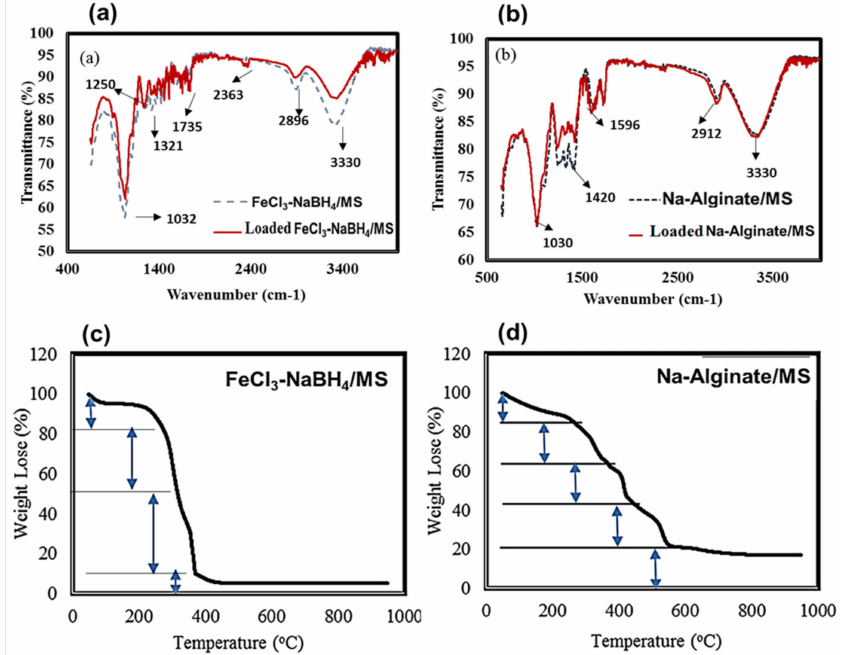
Figure 1. FTIR spectra of ( a ) FeCl 3 -NaBH 4 /MS hybrid composites and ( b ) Na-Alginate/MS compos- ite beads, both for loaded and unloaded 2,4,6-TCP, and TGA thermograms for ( c ) FeCl 3 -NaBH 4 /MS hybrid composites and ( d ) Na-Alginate/MS composite